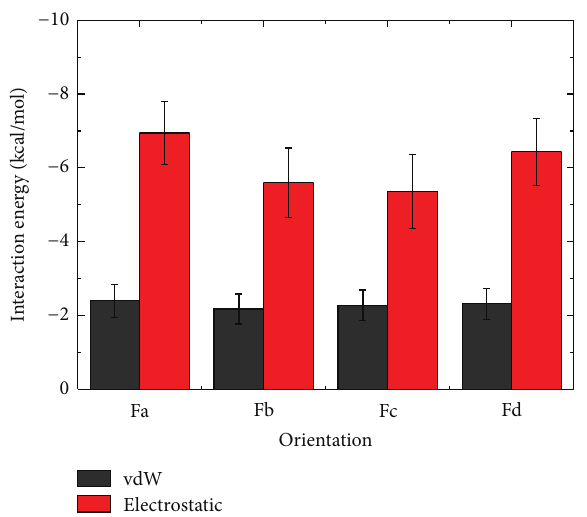
Figure 5: hIAPP-POPC interaction energy (per lipid) for hIAPP with four different binding orientations. The interaction energy is decomposed into the vdW (black) and electrostatic (red) component, calculated using the final 20 ns data of each MD run.